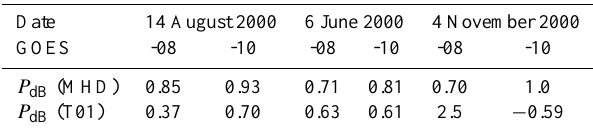
Table 1. P dB values, defined by Eq. (2), of the MHD and T01 field models respectively for the three presented